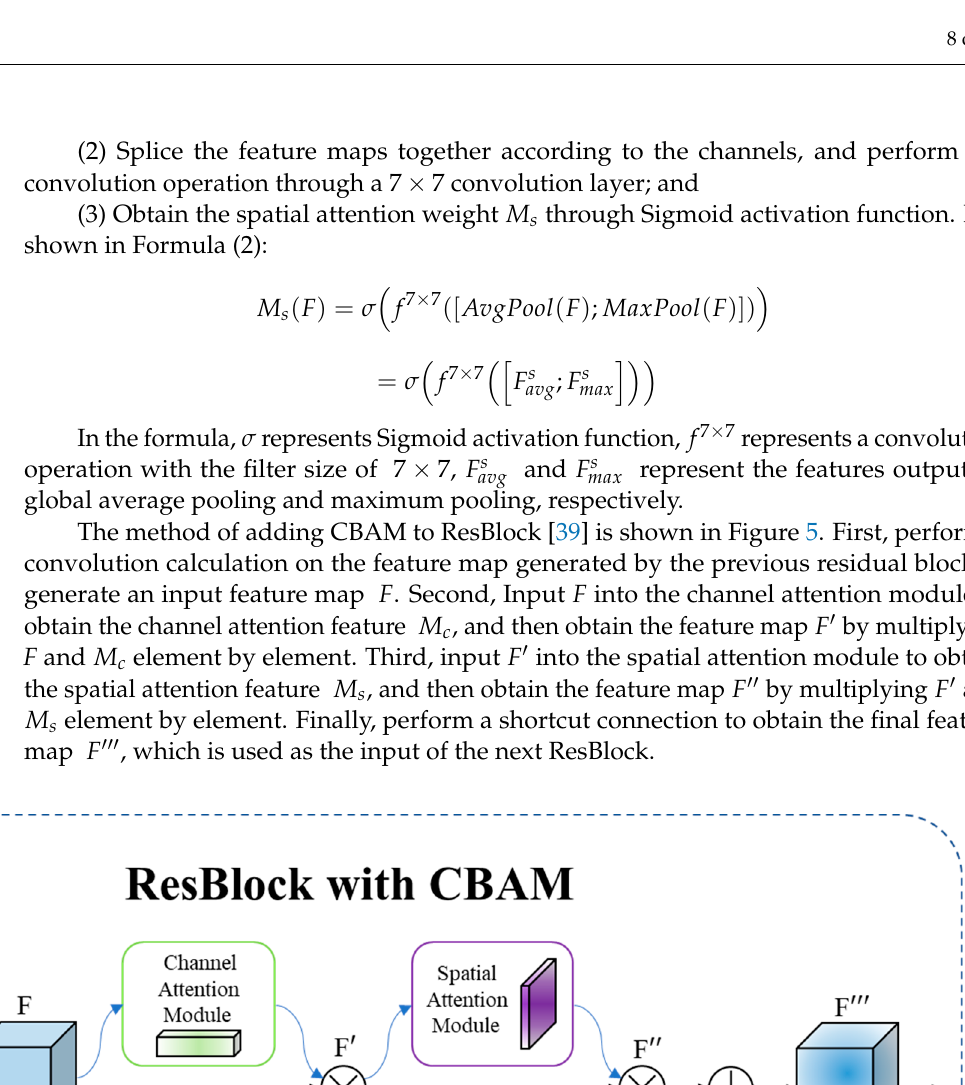
Figure 6. Structure of CBAM-DLA34.